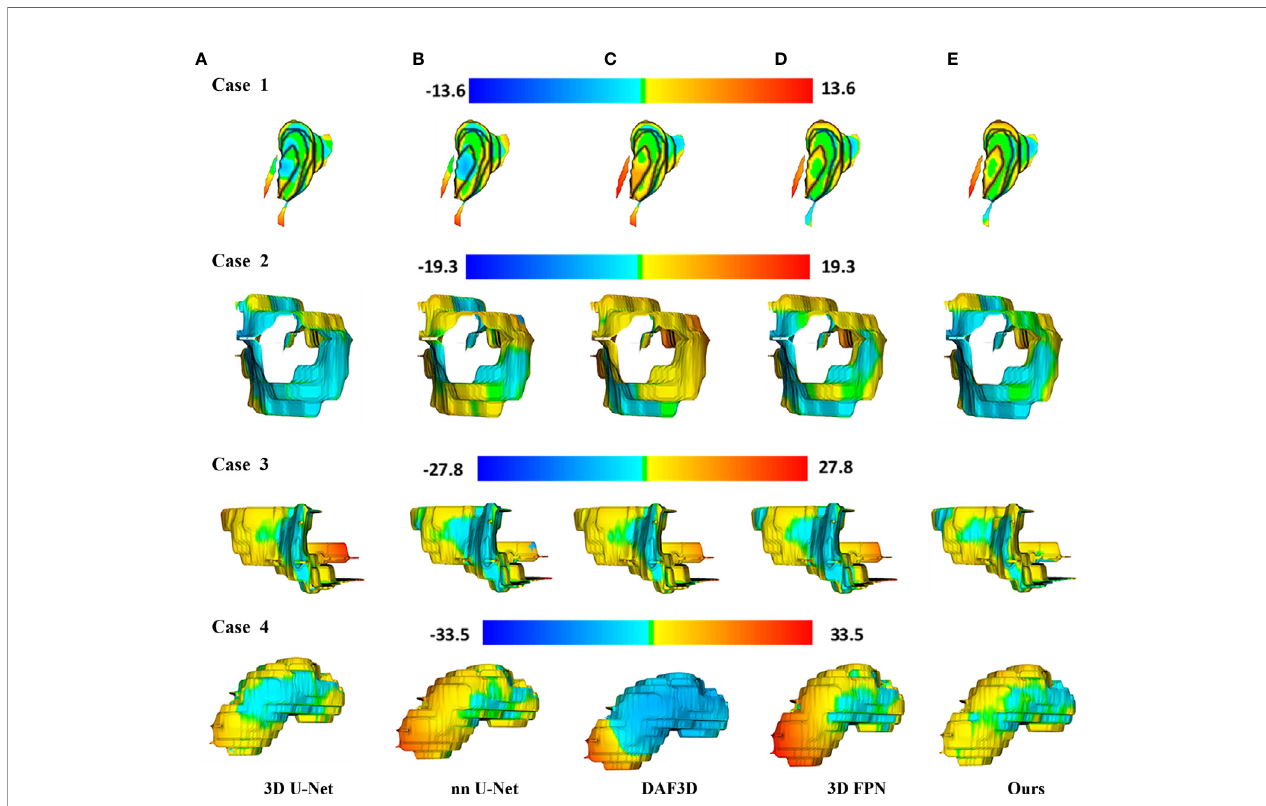
FIGURE 6 | 3D visualization of the surface distance (in voxel) between segmented surface and ground truth, with color bars relating to various surface distances. Rows denote segmentation outcomes on four different CT volumes respectively. Columns demonstrate the segmented surfaces generated by (A) 3D U-Net (10), (B) nnU-Net (32), (C) DAF3D (14), (D) 3D FPN (12), and (E) our method, respectively.